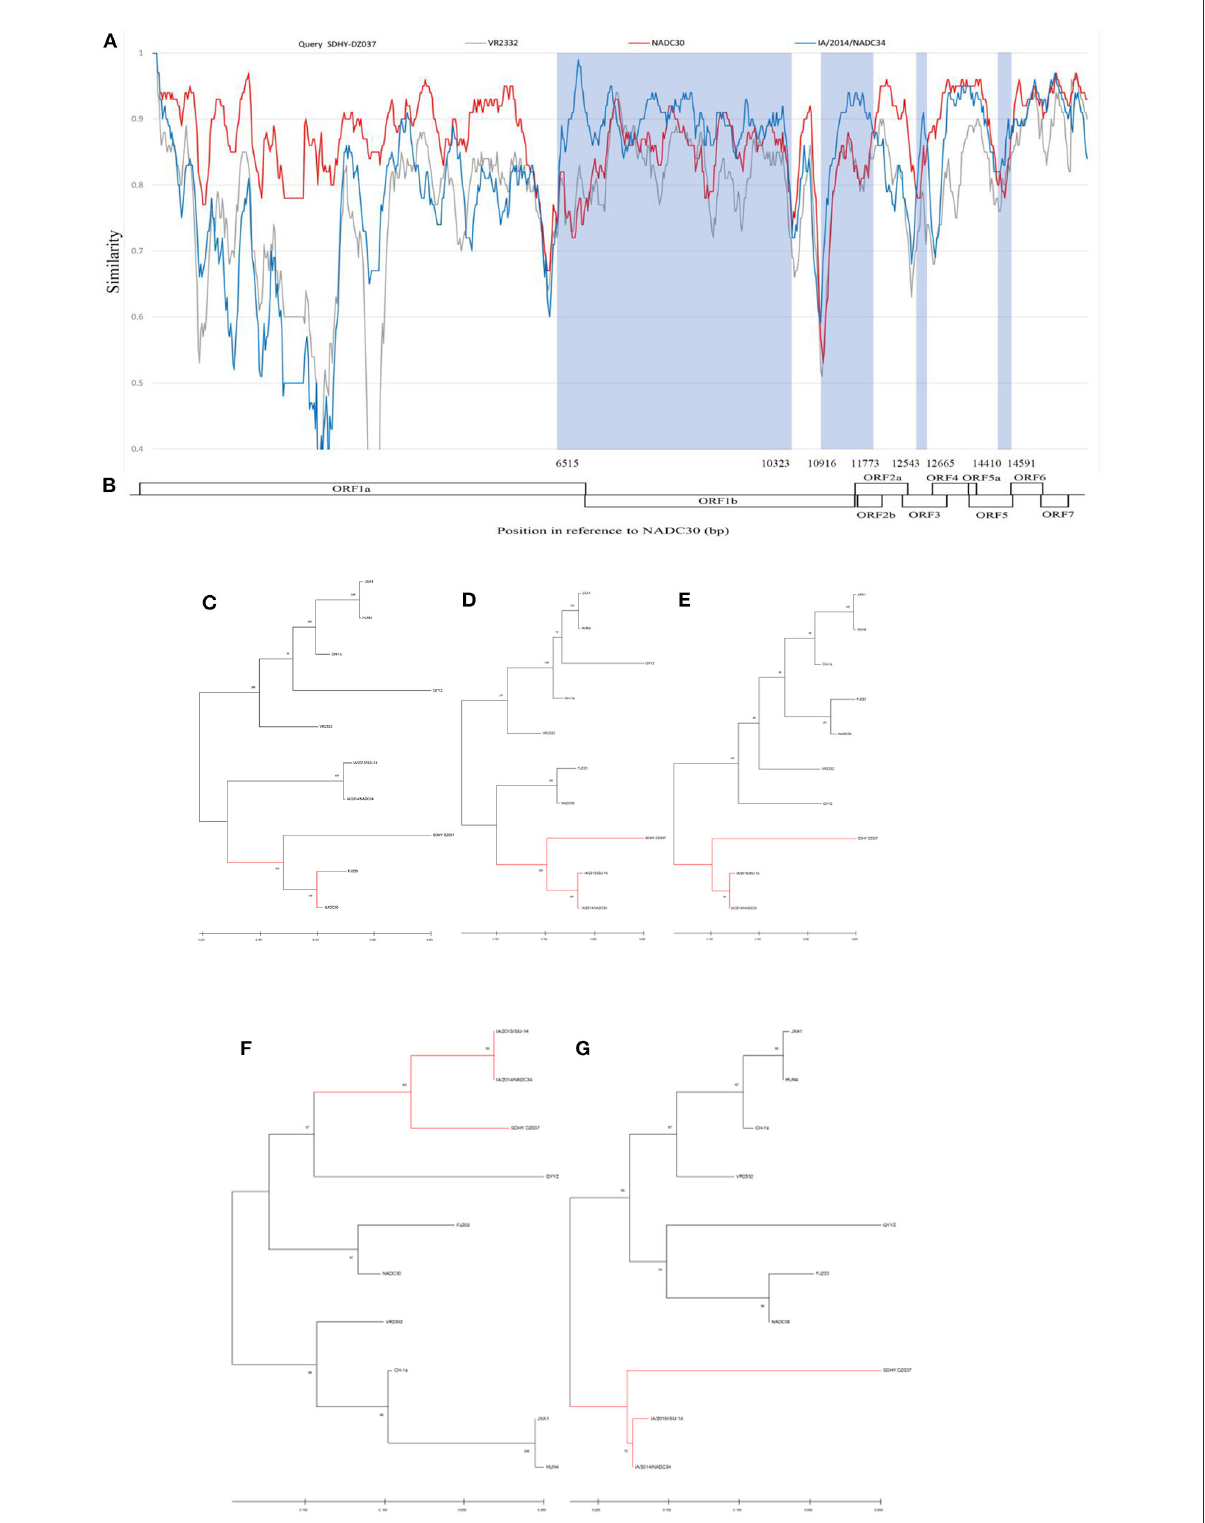
FIGURE5 In this study, the PRRSV representative strains and SDHY-DZ037 were selected for genome-wide recombination analysis. Similarity maps were generated by the SimPlot v3.5 software (A) . The gene region corresponding to the SDHY-DZ037 recombination was shown with NADC30 (GenBank: JN654459.1) (B) . Phylogenetic tree based on full-length genome sequence (C) . Phylogenetic tree of the nucleotide recombination